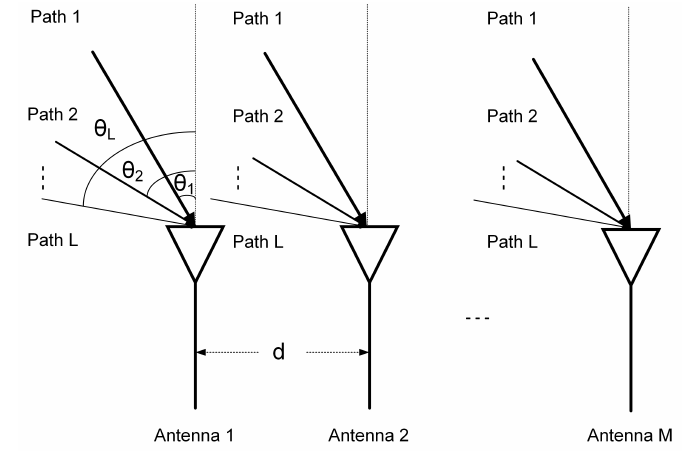
Figure 3. Uniform linear array of M receiving